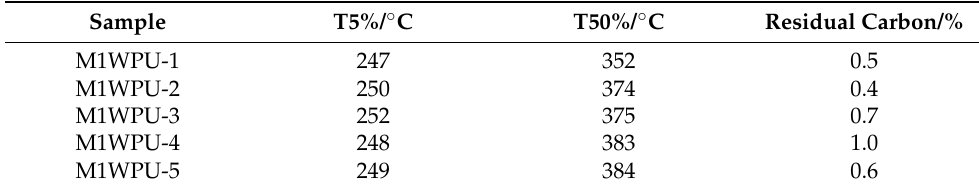
Figure 4. ( a ) TG and ( b ) DTG curves of HTPB-modified waterborne polyurethane. Table 5. TG data of different HTPB-modified WPU films.